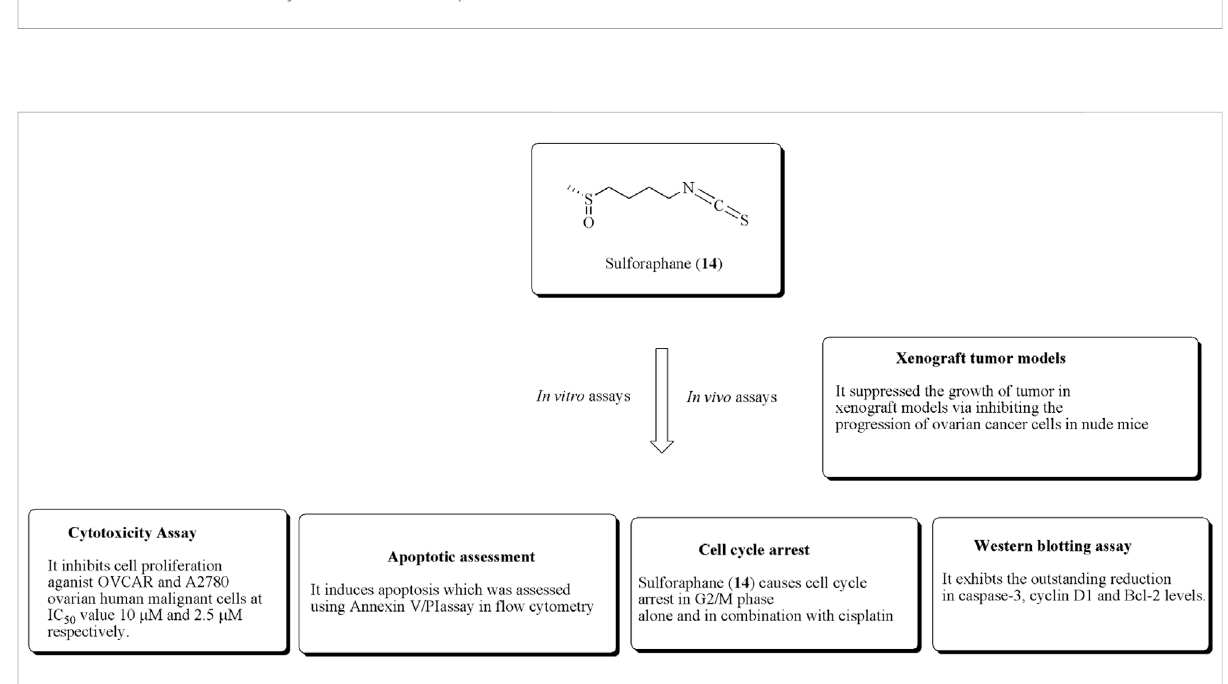
FIGURE 18 Antiproliferative effects of sulforaphane using in vitro and in vivo experiments. OVCAR and A2780 ovarian cell lines along with xenograft tumor models were used for this activity validation.